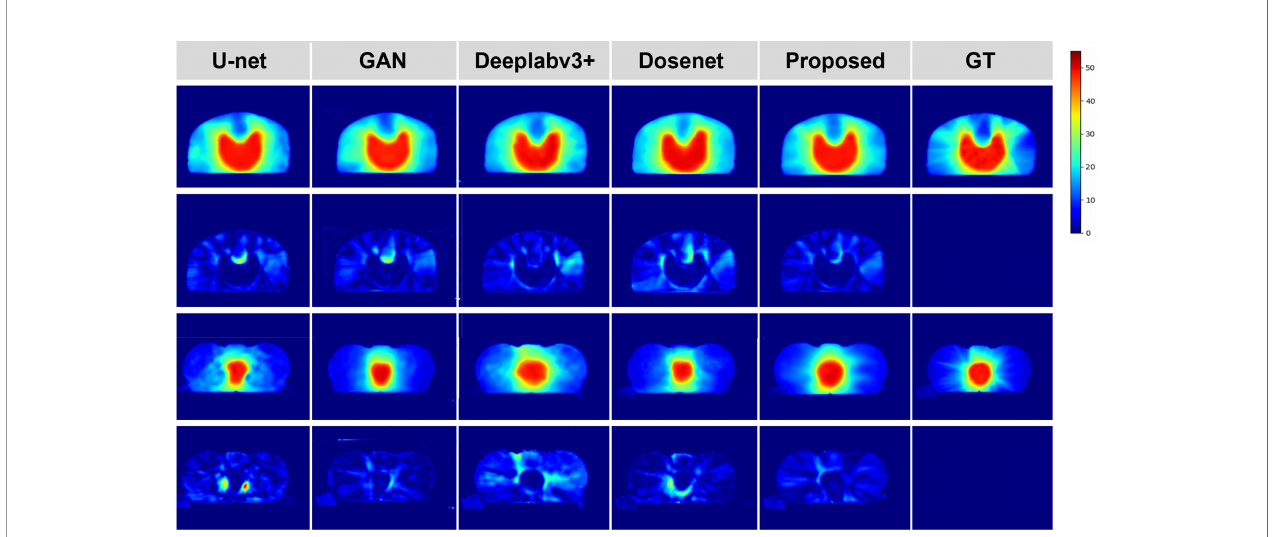
FIGURE 2 | Qualitative comparison between the predicted dose distributions for the proposed and four mainstream methods. The left four columns are the dose prediction results of the comparison methods, and the right two columns are the predicted dose distributions by our method and the ground truth, respectively. The second and fourth rows of the left fi ve columns are the difference maps calculated by subtracting the ground truth distribution map from the predicted one.